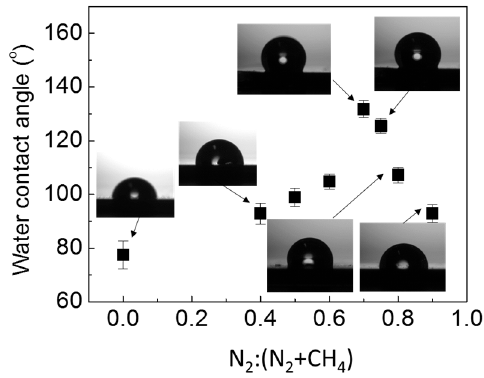
Figure 8. Variations in the contact anglefor CN x :H nanostructured films deposited at different N 2 :(N 2 + CH 4 ) flow rate ratios.